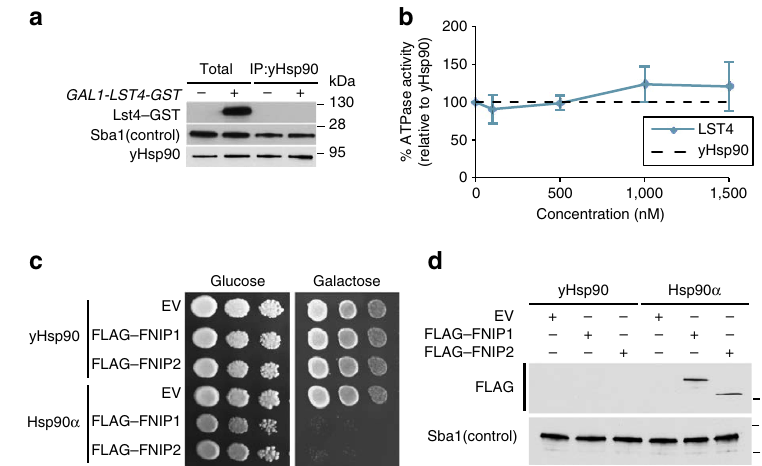
Figure 5 | Lst4 is not an orthologue of FNIPs in yeast. ( a ) BY4741 yeast strain expressing GAL1-LST4-GST was grown on either YPED (glucose) or YPGal (Galactose) media at 30 (cid:2) C for 8h. Endogenous yHsp90 immunoprecipitation (IP) and co-IP Lst4-GSTwas detected by immunoblotting. ( b ) In vitro ATPase activity of the yHsp90–His 6 with indicated amounts Lst4-GST. All the data represent mean ± s.d. ( c ) PP30 strain expressing either yHsp90 or Hsp90 a as the sole copies of Hsp90 were transformed by GAL1–FLAG–FNIP1 or GAL1–FLAG–FNIP2. Cells were spotted at 1:10 dilution series on YPED or YPGal media. Plates were incubated at 30 (cid:2) C for 2 days. ( d ) Yeast strains in i were grown on YPGal liquid media for 12h and the expression of FLAG–FNIP1 and FLAG–FNIP2 were examined by